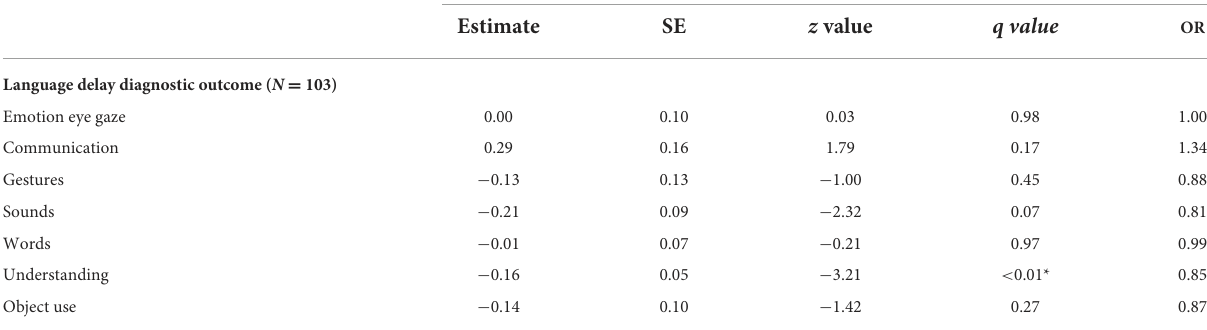
TABLE 9 Logistic regression analysis exploring main effects of social communication skills measured at 24-months on language outcomes measured at 36-months in HL-infants. CSBS